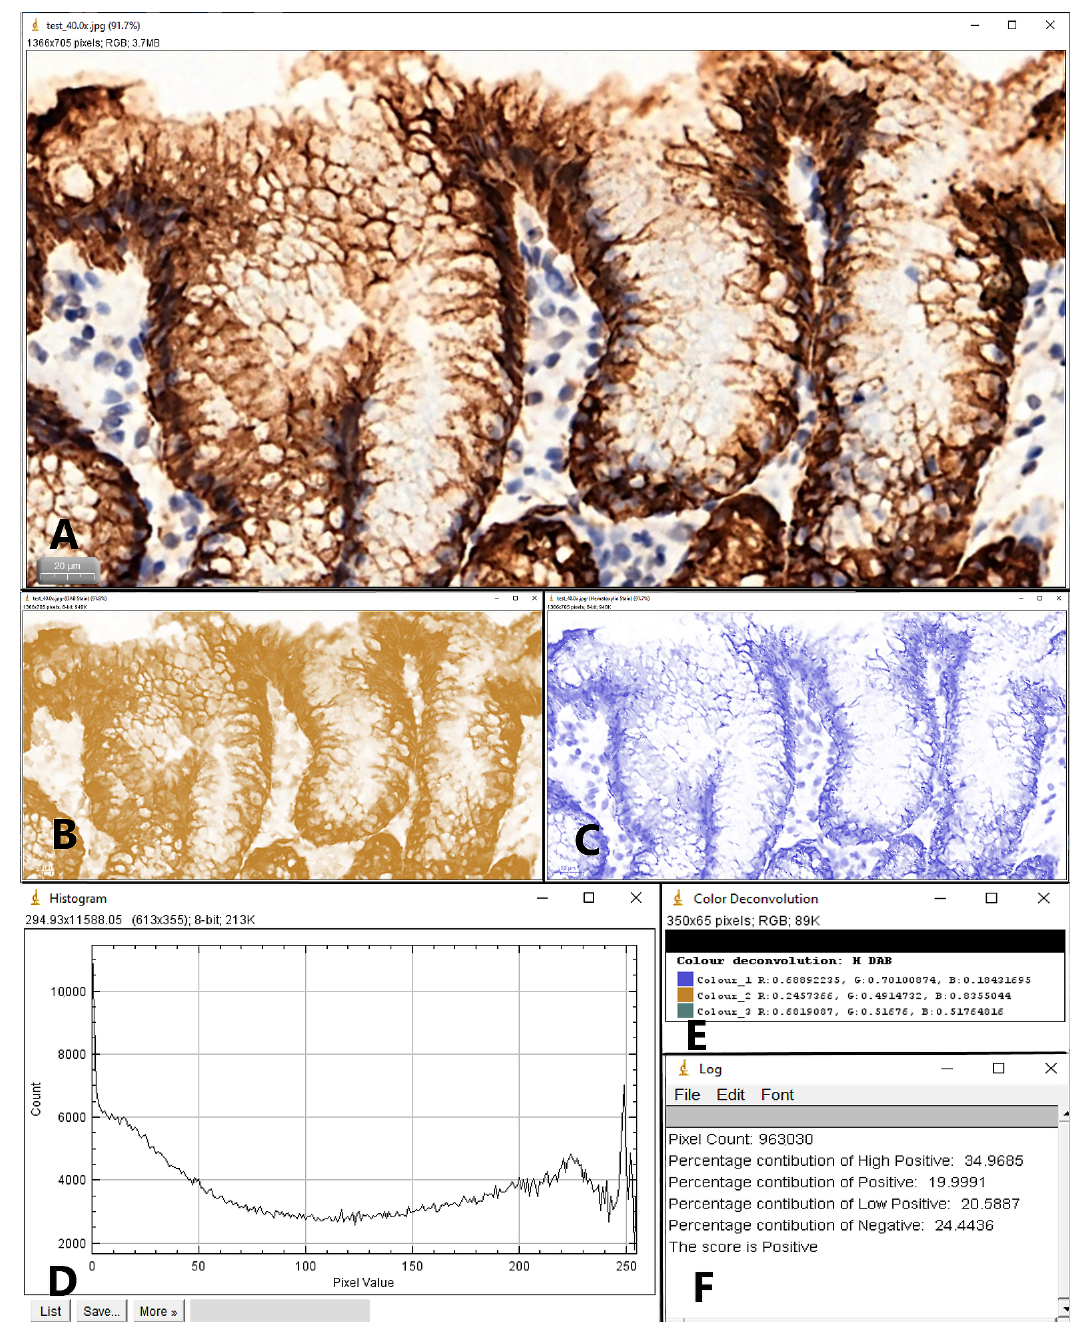
Figure 1. Example of color deconvolution for a MUC5AC stained slide (40 × objective × magnification) using the IHC Profiler Plugin for ImageJ, in order to determine the Optical Density Score. ( A ) Sample image; ( B ) DAB stain; ( C ) Hematoxylin stain; ( D ) The histogram profile for the pixel intensity; ( E ) Color deconvolution values; ( F ) The intensity percentages used for the assignment of the score. ODS = (percentage of high positive × 4 + percentage of positive × 3 + percentage of low positive × 2 + percentage of negative × 1) /